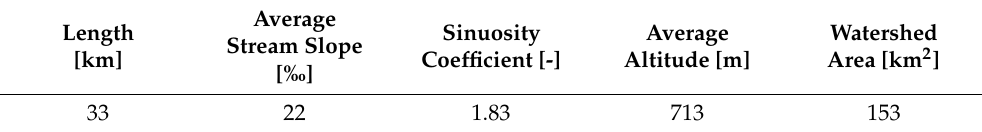
Table 3. The morphometric characteristics.